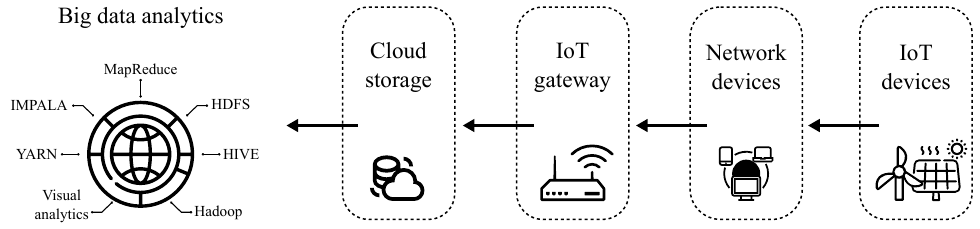
Figure 4. Working of IoT, cloud, and big